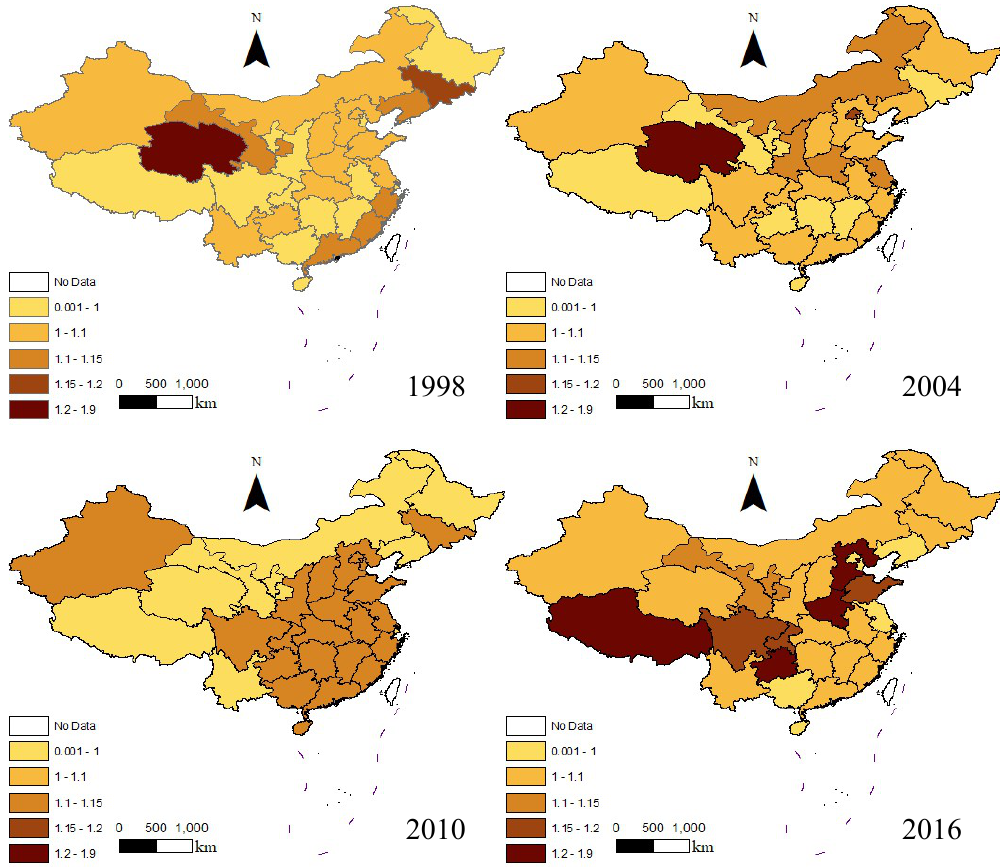
Figure 5. The spatial distribution of China’s agricultural GTFPI in 1997, 2004, 2010 and 2016.